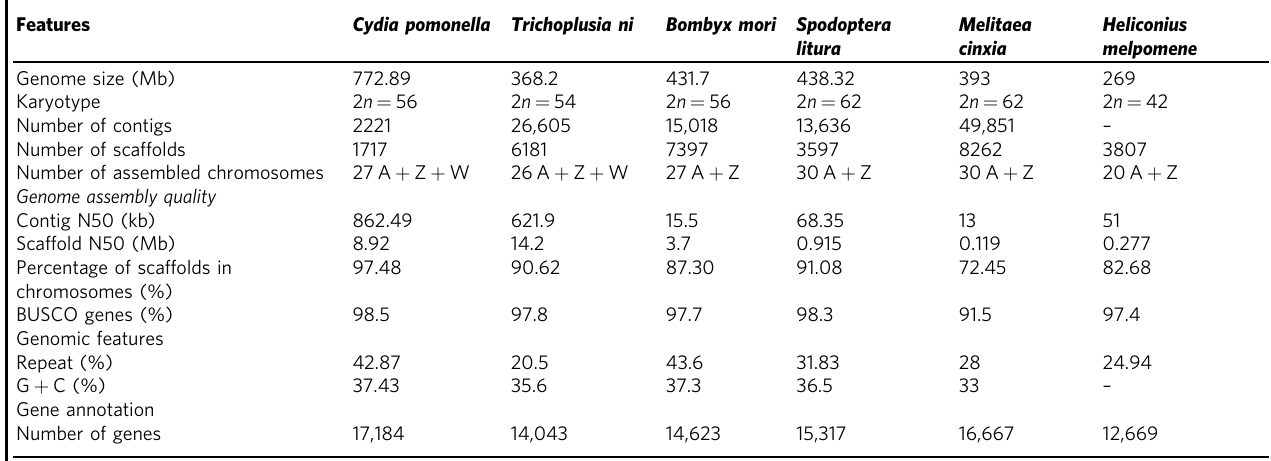
Table 1 Chromosome-level assembled Lepidoptera genomes